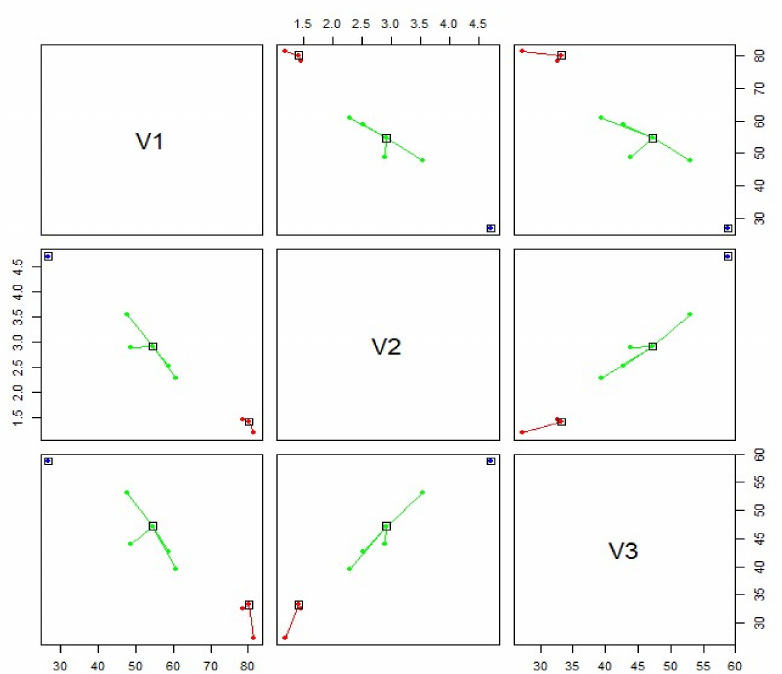
Figure 8. Clustering result (confirmation dataset) for two-response combinations (three-cluster